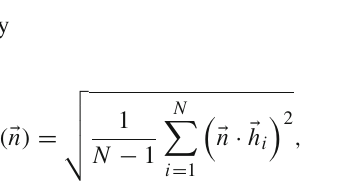
points if they are not varying) relation between n T and k 1 − k 2 , and θ − α (from analytical calculation). Here, we have fixed (cid:2) = (cid:2) all